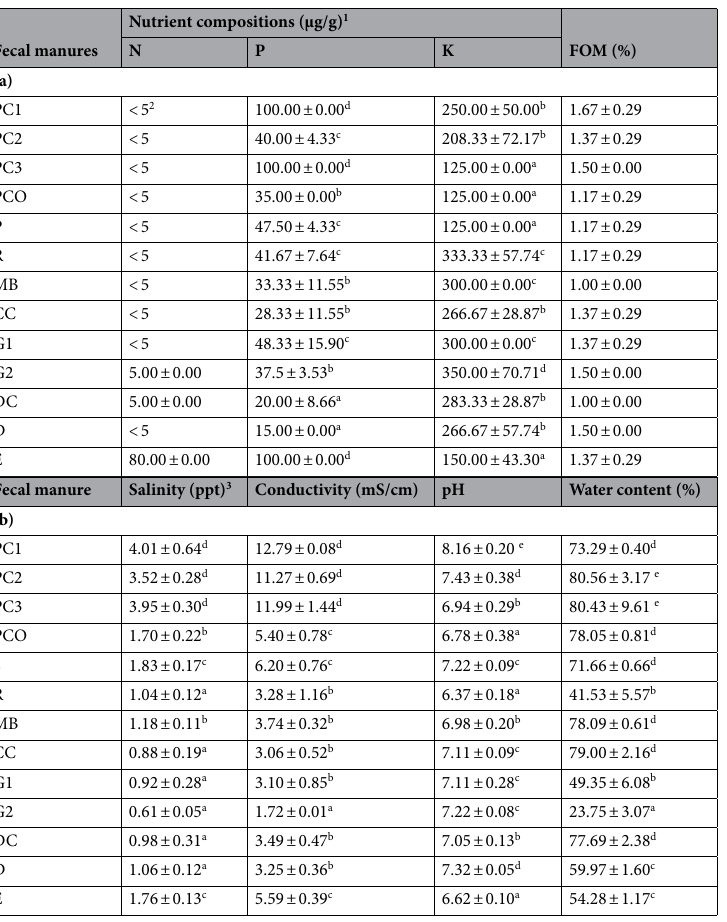
Table 1. Characteristics of (a) NPK and FOM, and (b) physiochemical levels of the different animal fecal manures. Different lowercase letter superscripts within the same column denote a significant difference (ANOVA, p < 0.05). 1 Data are shown as the mean ± SD of three independent measurements. 2 Measurement could not be specified when < 5 µg/g. 3 ppt is parts per